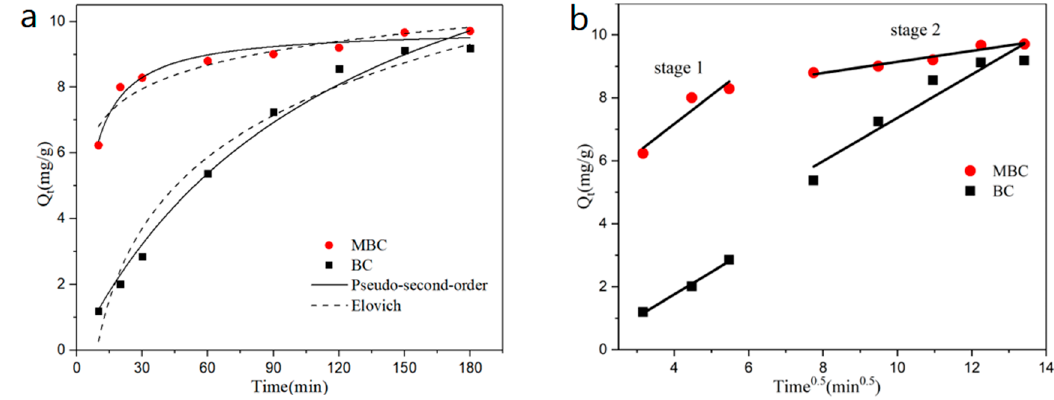
Figure 3. Effects of BC and MBC dosage on BPA adsorption.